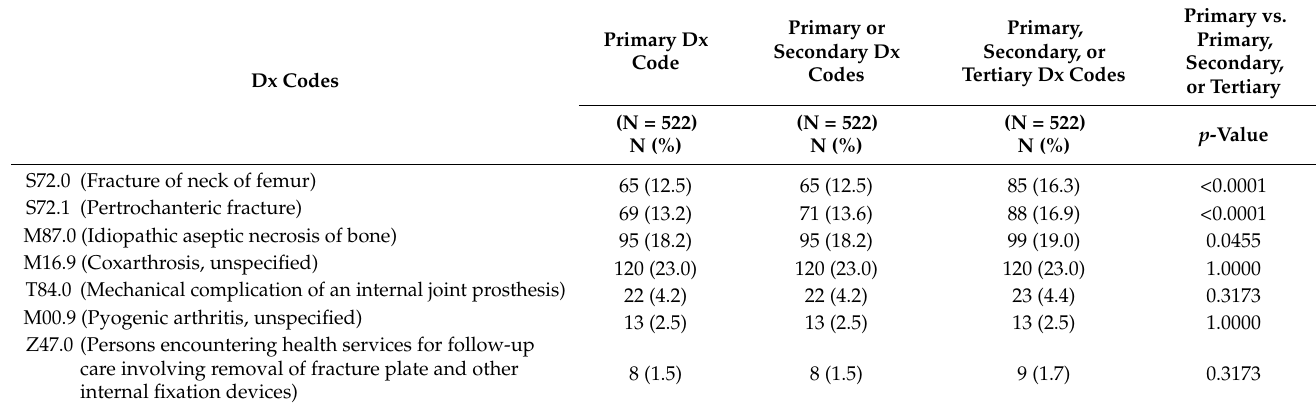
Table 2. Patients’ diagnosis codes according to the diagnosis code levels listed in the claims data.